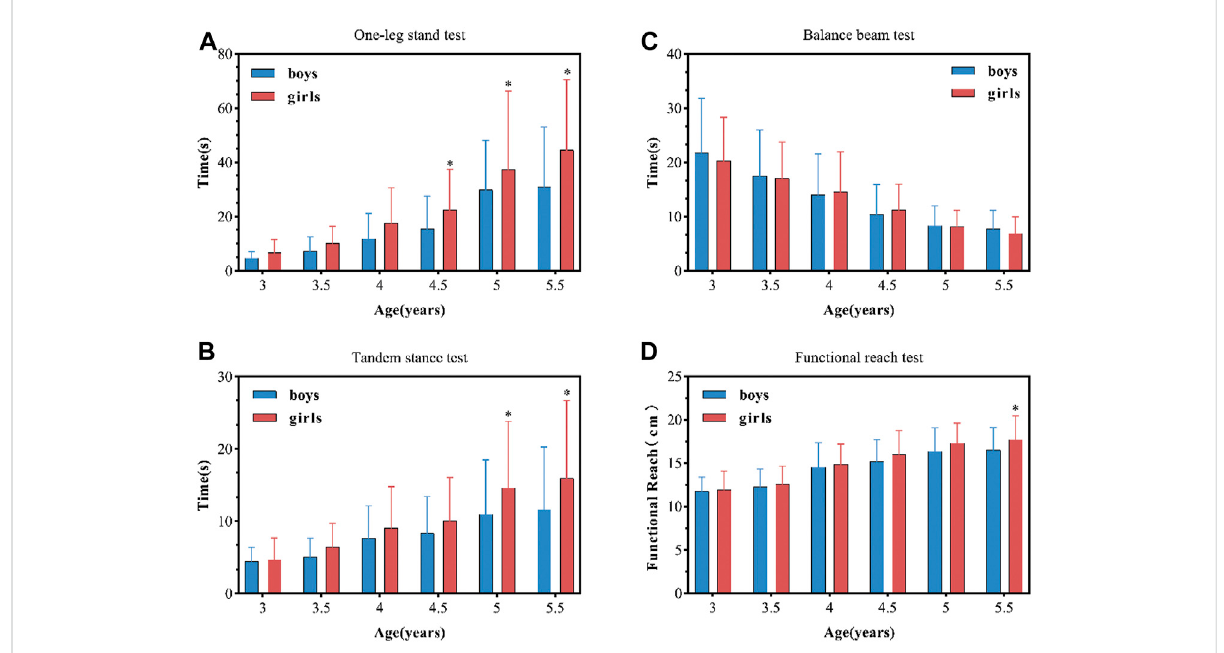
FIGURE 2 Balance performances of boys and girls. Balance performance (mean ± standard deviation) of boys and girls. The (*) indicates a signi fi cant difference between genders at p < 0.05. (A) One-leg stand test, (B) tandem stance test, (C) balance beam test, (D) functional reach